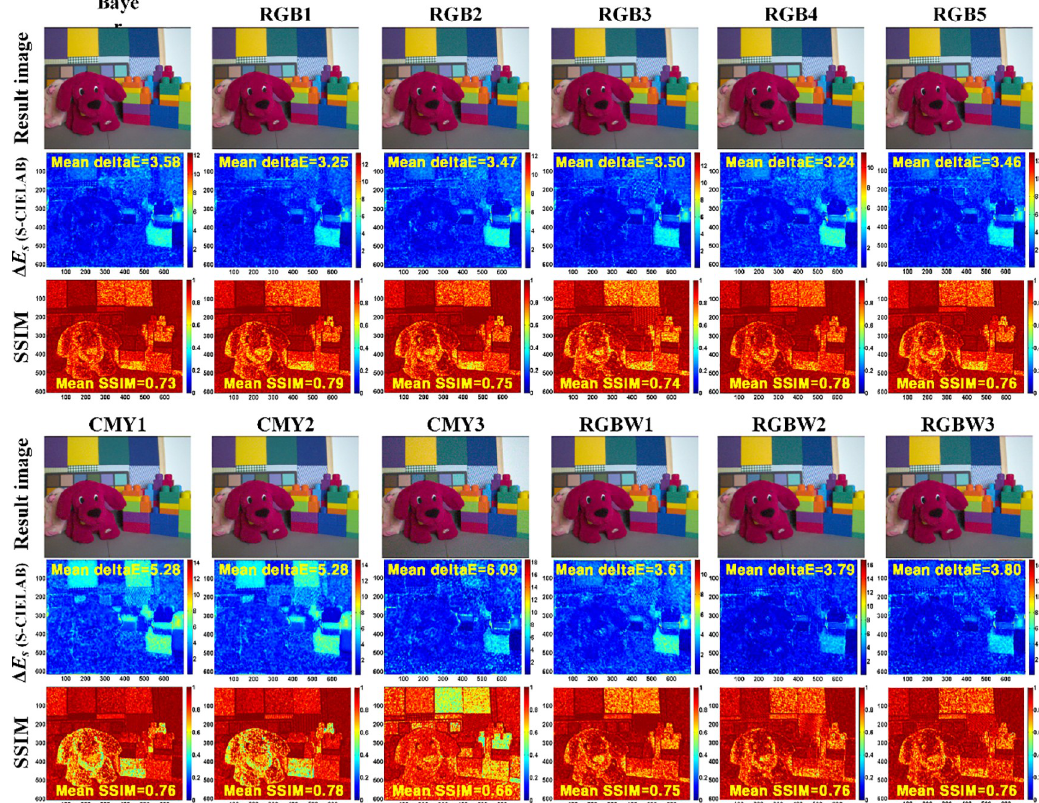
Fig 10. Color reproduction error using S-CIELAB and structural information results using SSIM for test CFAs.